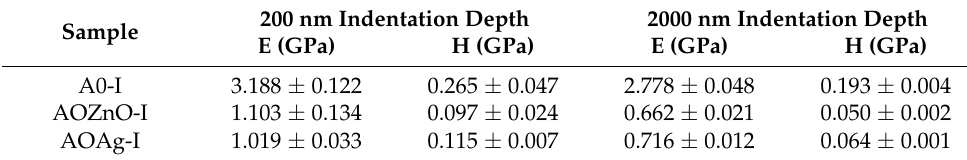
Figure 3. Representative curves for ( a ) hardness, ( b ) elastic modulus, and ( c ) load as a function of indentation depth where blue line = A0-I, orange line = AOAg-I, and green line = AOZnO-I. Table 2. Values recorded for E and H at different indentation depths, results are expressed as mean ± standard deviation, n =